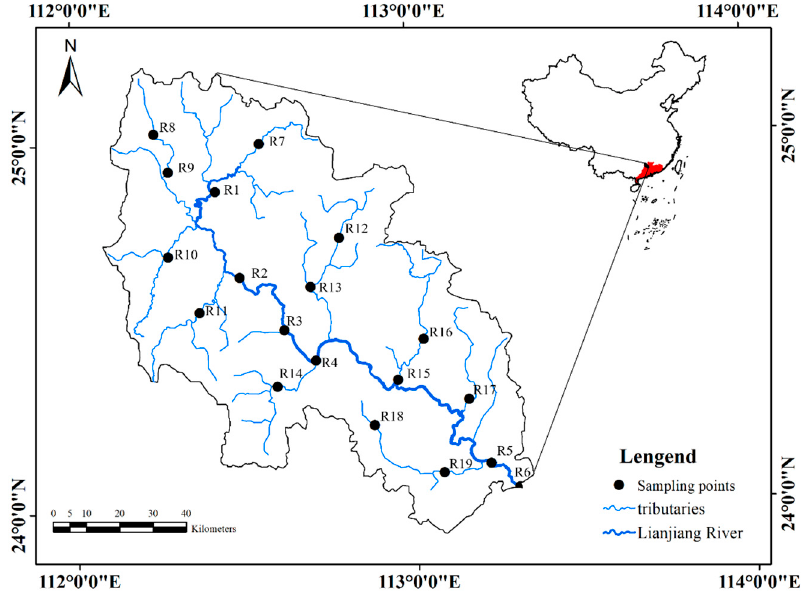
Figure 1. Map of the Lianjiang River (LJR) and the locations of the sampling points, the red area is Guangdong province.